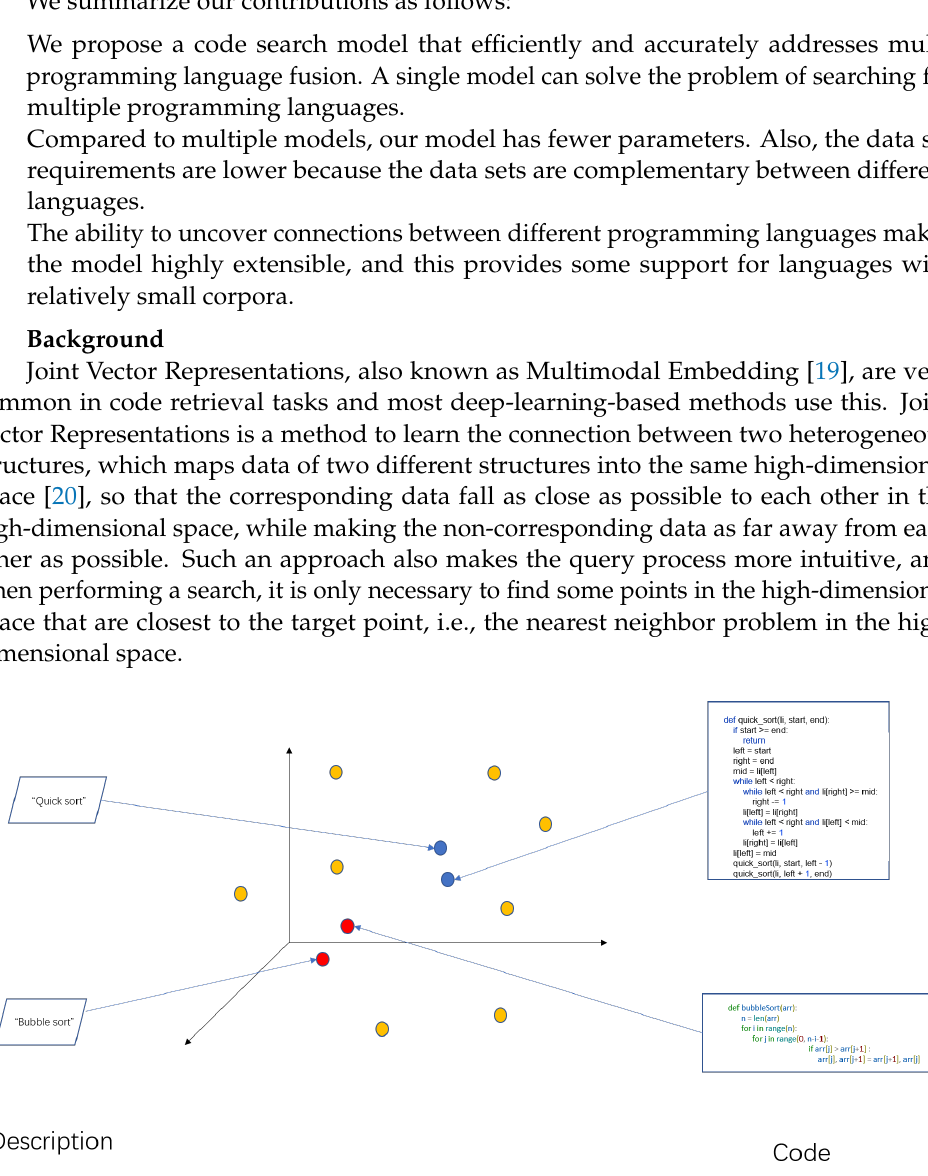
Figure 1. Conceptual diagram of joint embedding in a code search